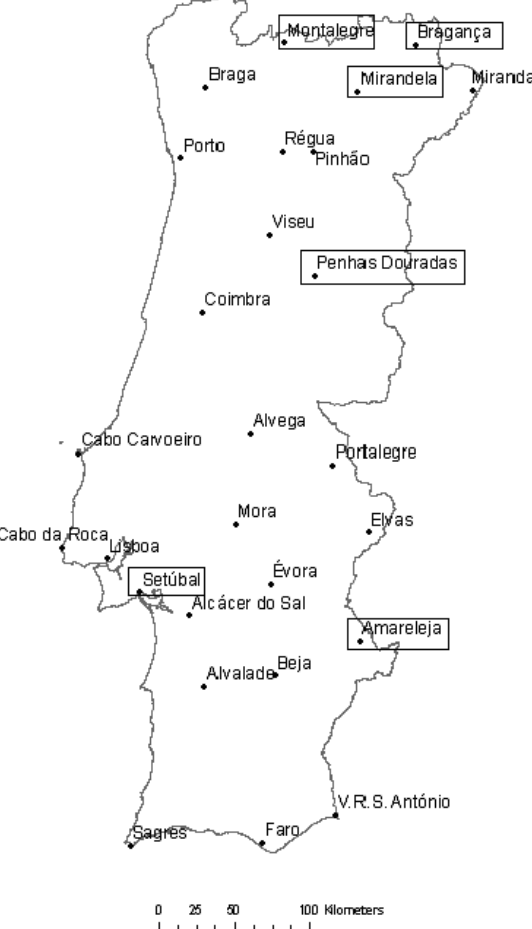
Fig. 1. Locations of the weather stations with identification of those used as examples in this